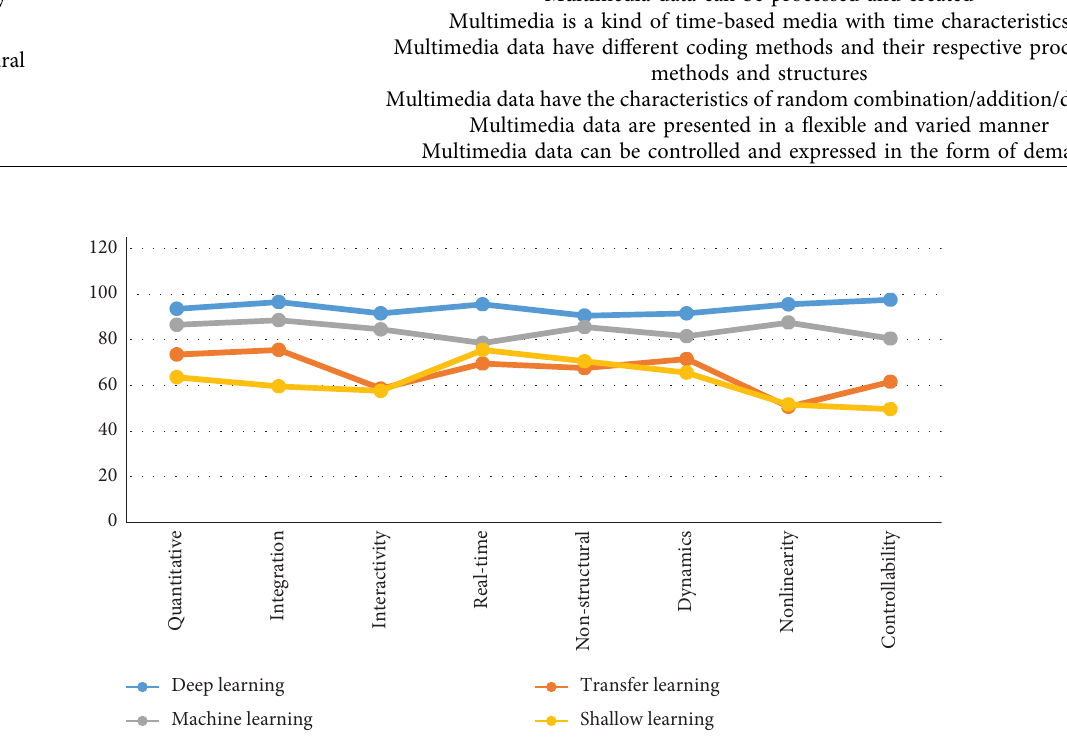
Figure 9: Correlation analysis and comparison of multimedia data features by deep